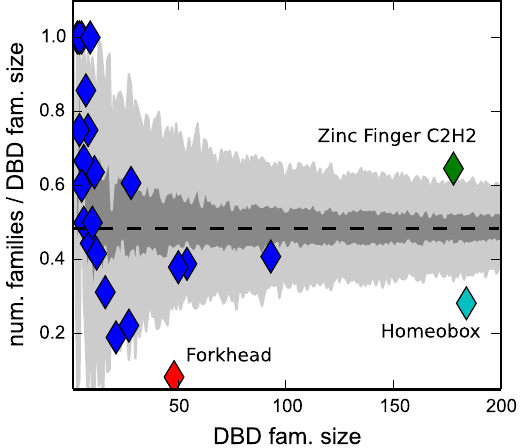
Figure 4. Splitting of DBD families in motif families. The ratio F / N is plotted as a function of the number of TFs of the DBD family. Each point represents the empirical value for a DBD family, while the dashed line represents the expected value for θ = 0.74 as given by Eq. 4. In order to evaluate the fluctuations on the expectation, we simulated the evolution of 5 * 10 4 DBD families, with starting size ranging from 1 to 500, θ = 0.74 and λ = δ . The two shaded areas correspond to 1 standard deviation and 3 standard deviations from the average. Green diamond: Zinc Finger C2H2 family. Cyan diamond: Homeobox family. Red diamond: Forkhead family.